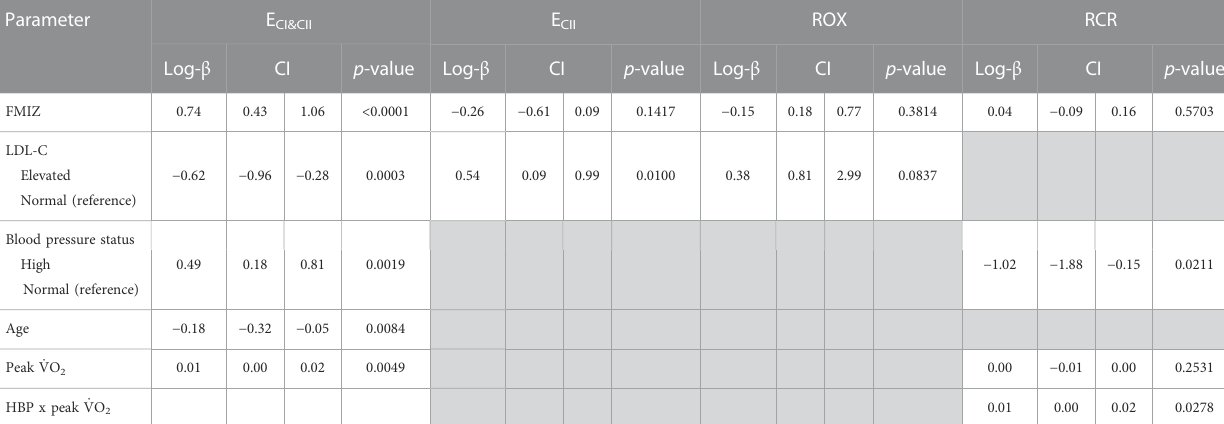
TABLE 6 Multiple Generalized linear regression analysis modeling the association of converged maximal uncoupled electron transport capacity of CI and CII, CII alone, residual oxygen consumption, and respiratory control ratio. Parameter